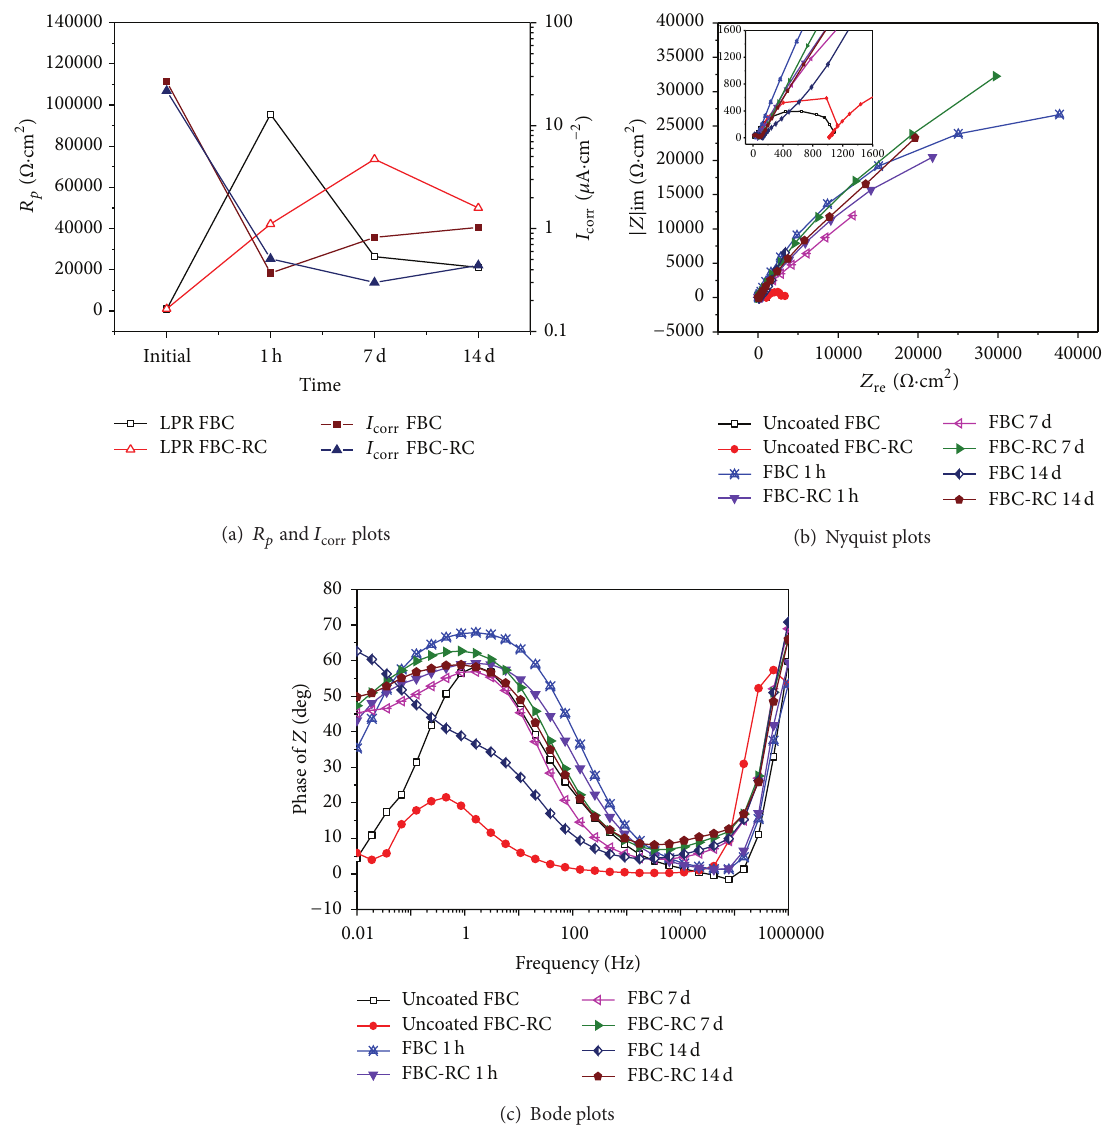
Figure 4: LPR and EIS plots of electrodes coated with FBC and FBC-RC in chloride